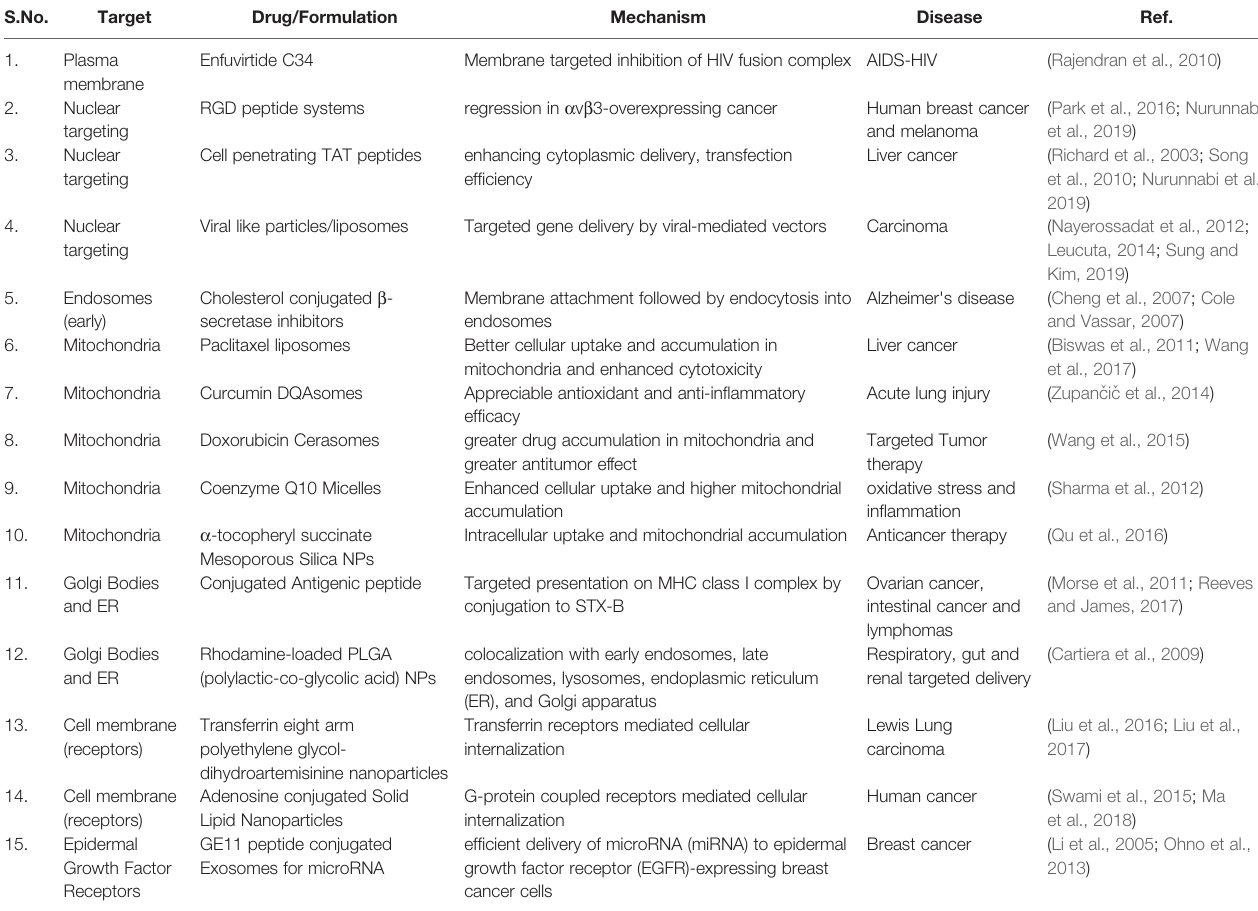
TABLE 2 | Types of subcellular targeted drug delivery